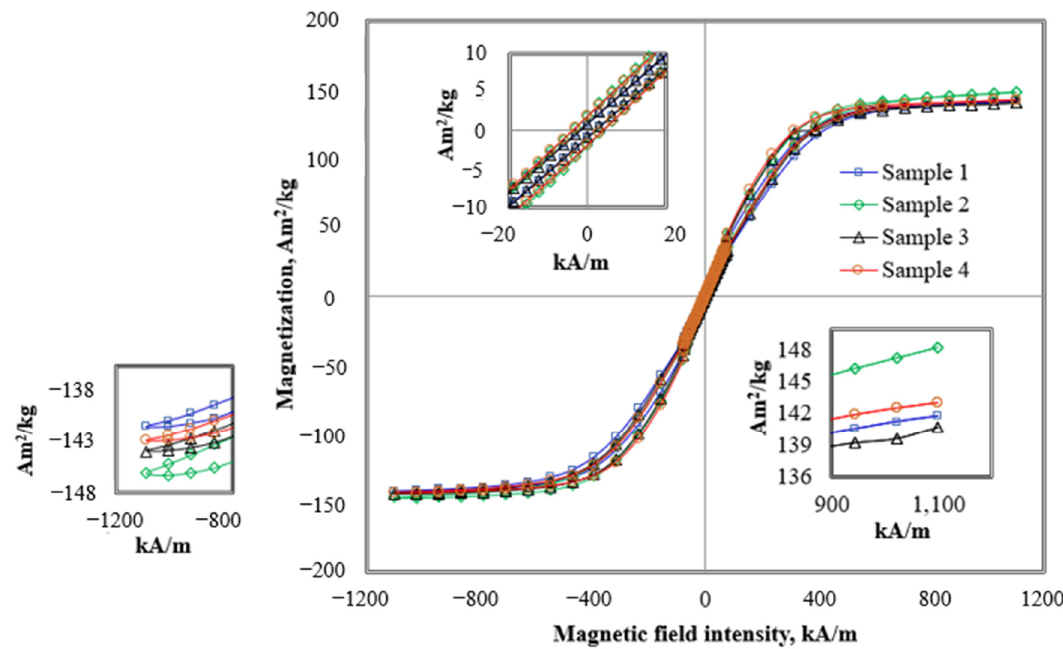
Figure 1. The magnetic properties of MRE samples.